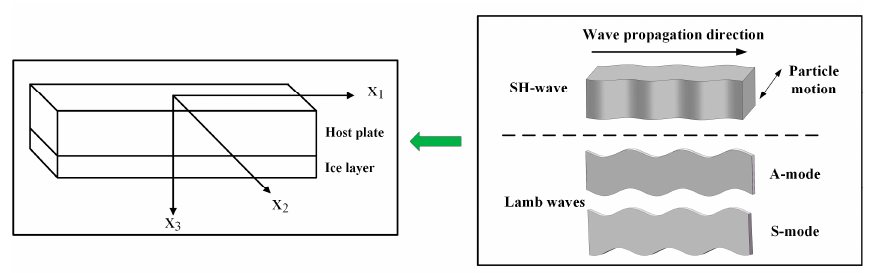
Figure 1. The coordinate system and ultrasonic waves propagating in the ice-plate layered structure.